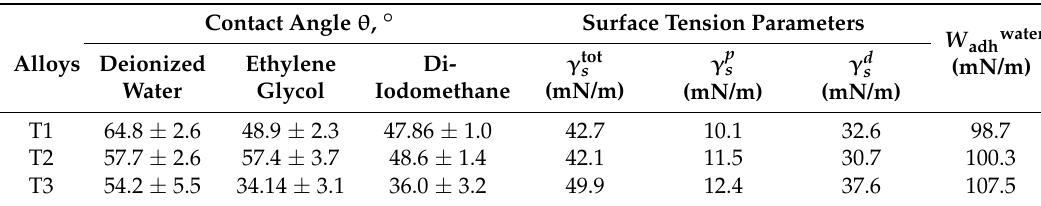
Table 5. Contact angle values, the surface free energy components and the work of adhesion for deionized water ( W adhwater ). Contact Angle θ , ◦ Surface Tension Parameters Alloys